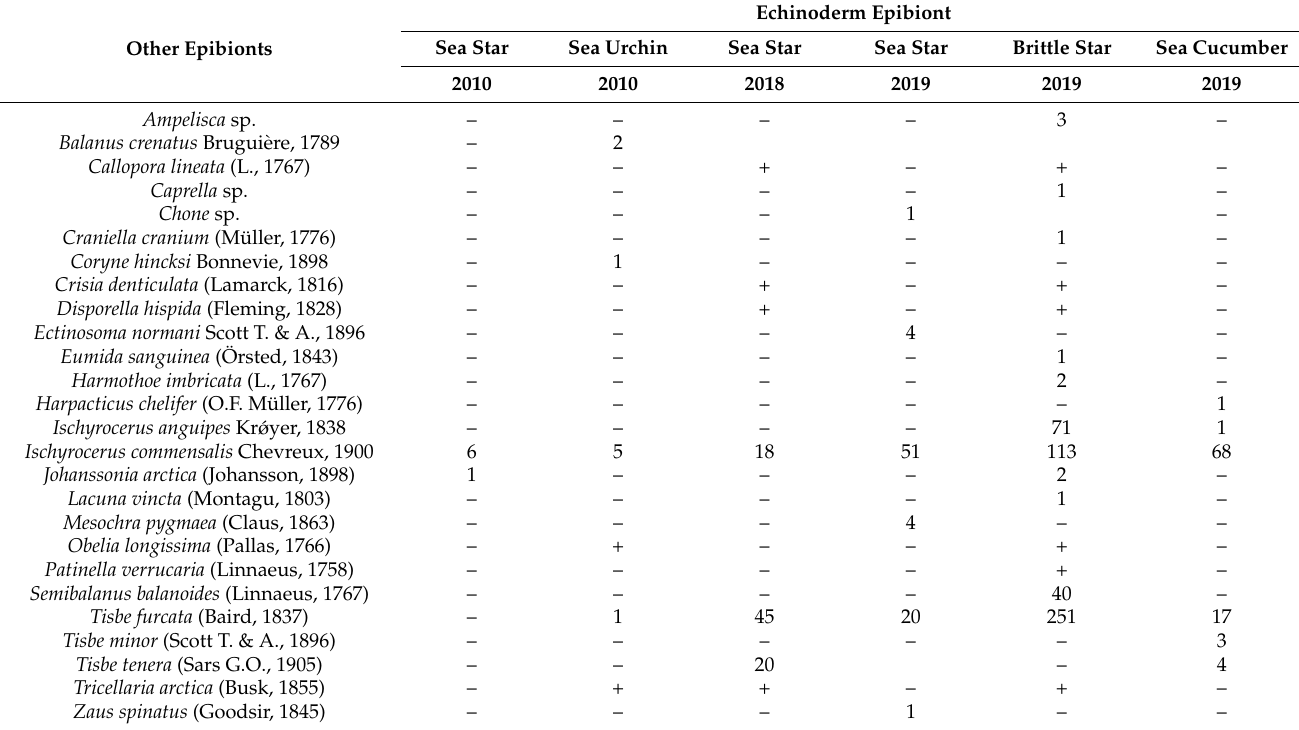
Table 1. Intensity of epibionts found on red king cabs together with echinoderms in Dalnezelenetskaya Bay, Barents Sea in 2010, 2018, and 2019.